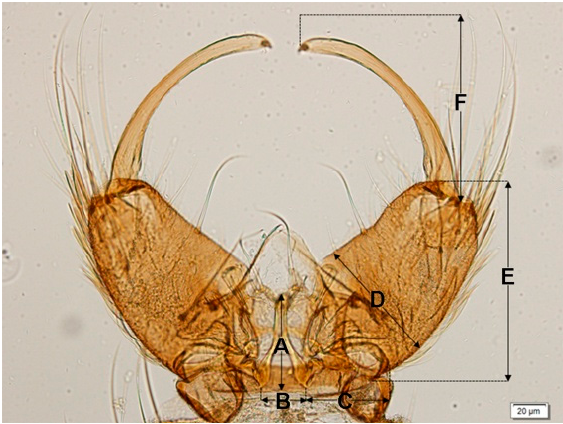
Figure 3. Measurements of the male genitalia (ventral view) at various sites: ( A ) length of the aedeagus; ( B ) width of the aedeagus; ( C ) length between the base of the aedeagus and origin of the gonocoxite; ( D ) width of the gonocoxite at the origin of the parabasal seta; ( E ) Length of the gonocoxite; and ( F ) length of the gonostylus. Scale bar: 0.02 mm.